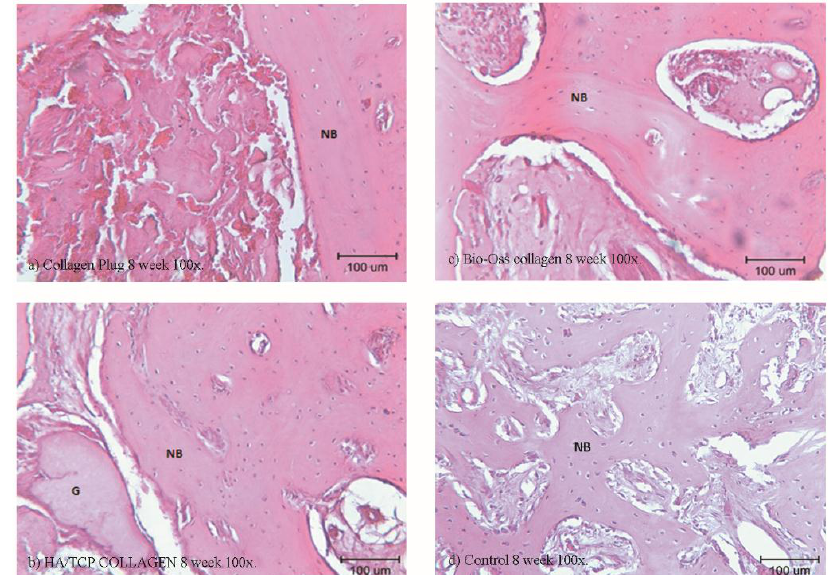
Figure 8. Histological examination at the eight week using 100× magnification. Histological analysis of the collagen ( a ), bovine xenograft-collagen composite ( b ), hydroxyapatite/β-tricalcium phosphate (HA/β-TCP)-collagen composite ( c ) and control groups ( d ). Hematoxylin and eosin staining; original magnification: 100×. Abbreviations: NB, newly-formed bone; G, granule residual.